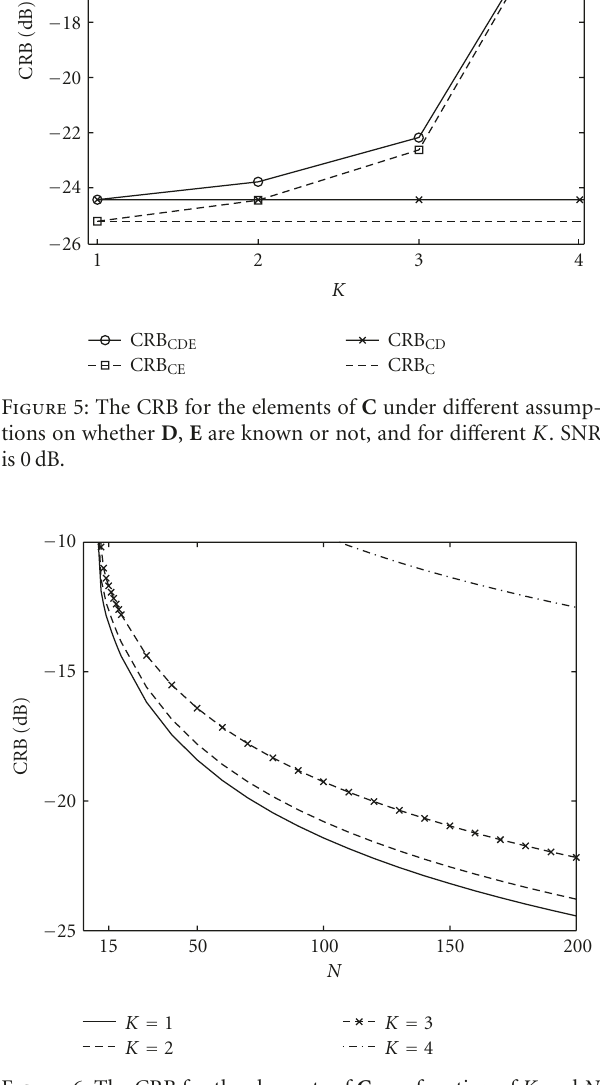
Figure 6: The CRB for the elements of C as a function of K and N when SNR is 0